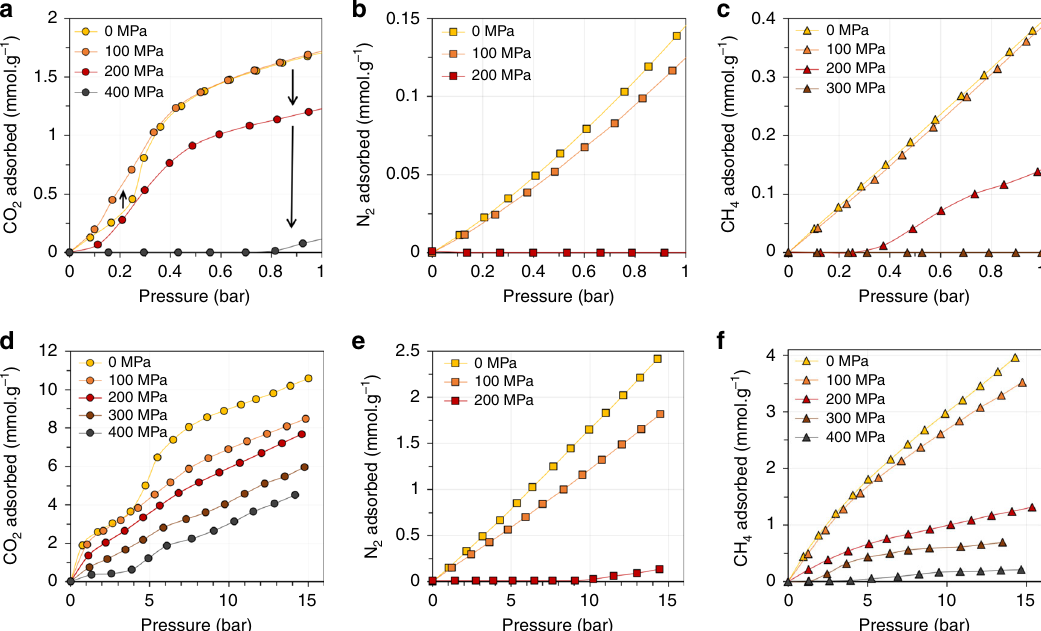
Fig. 2 Effect of mechanical pressure on CO 2 , N 2 , and CH 4 adsorption properties of MIL-53(Al). a – f Adsorption isotherms of CO 2 ( a , d circles), N 2 ( b , e squares), and CH 4 ( c , f triangles) recorded at 303 K for different applied mechanical pressures. a – c correspond to isotherms recorded up to 1 bar while d – f correspond to isotherms recorded up to 15 bar. Yellow, orange, red, brown, and dark gray fi lled symbols represent an applied mechanical pressure of 0, 100, 200, 300, and 400 MPa, respectively. a Black arrows indicate the evolution of CO 2 uptake when gradually increasing the mechanical